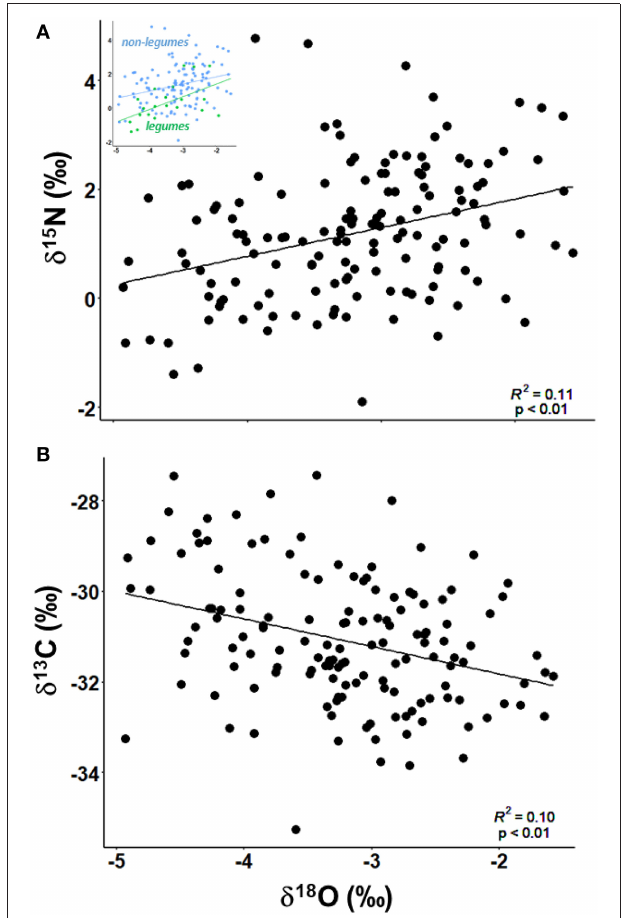
FIGURE 1 | Relationships between δ 18 O from stem water and δ 15 N [ (A) ; R 2 = 0.11, p < 0.01] and δ 13 C [ (B) ; R 2 = 0.10, p < 0.01] from leaves among individual trees. The inset in (A) depicts the linear regressions for non-legumes ( R 2 = 0.07, p < 0.01) and legumes ( R 2 = 0.26, p = 0.01).